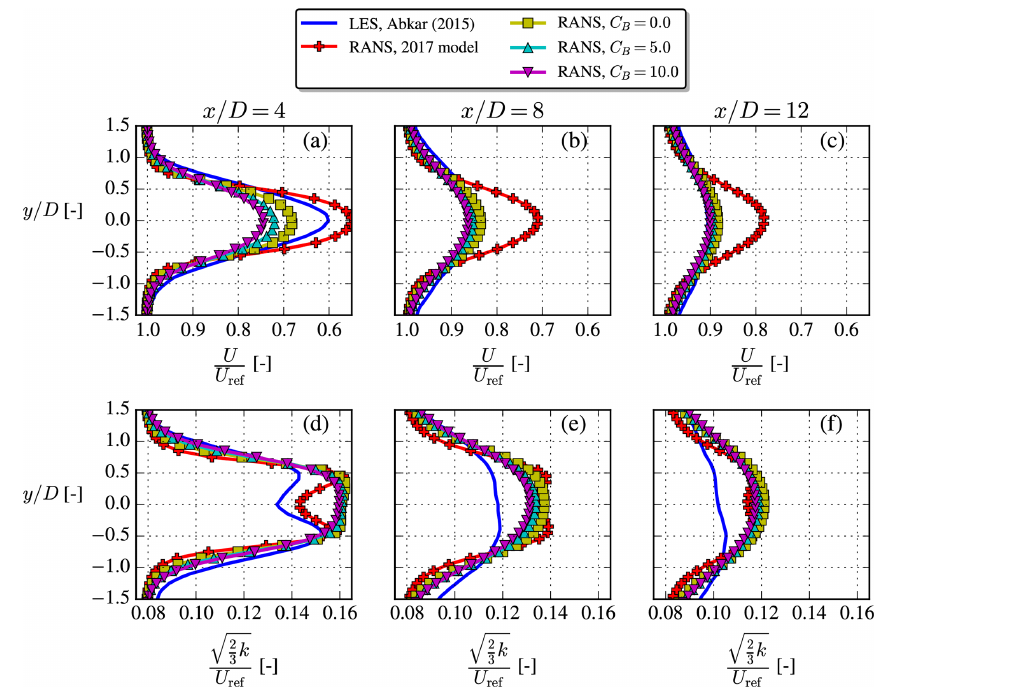
Figure 12. The unstable V80-Abkar case, where LES results were digitized from Abkar and Porté-Agel (2015). Profiles extracted at z = z ref . Note that total TI (d–f) is based on U ref and not the local